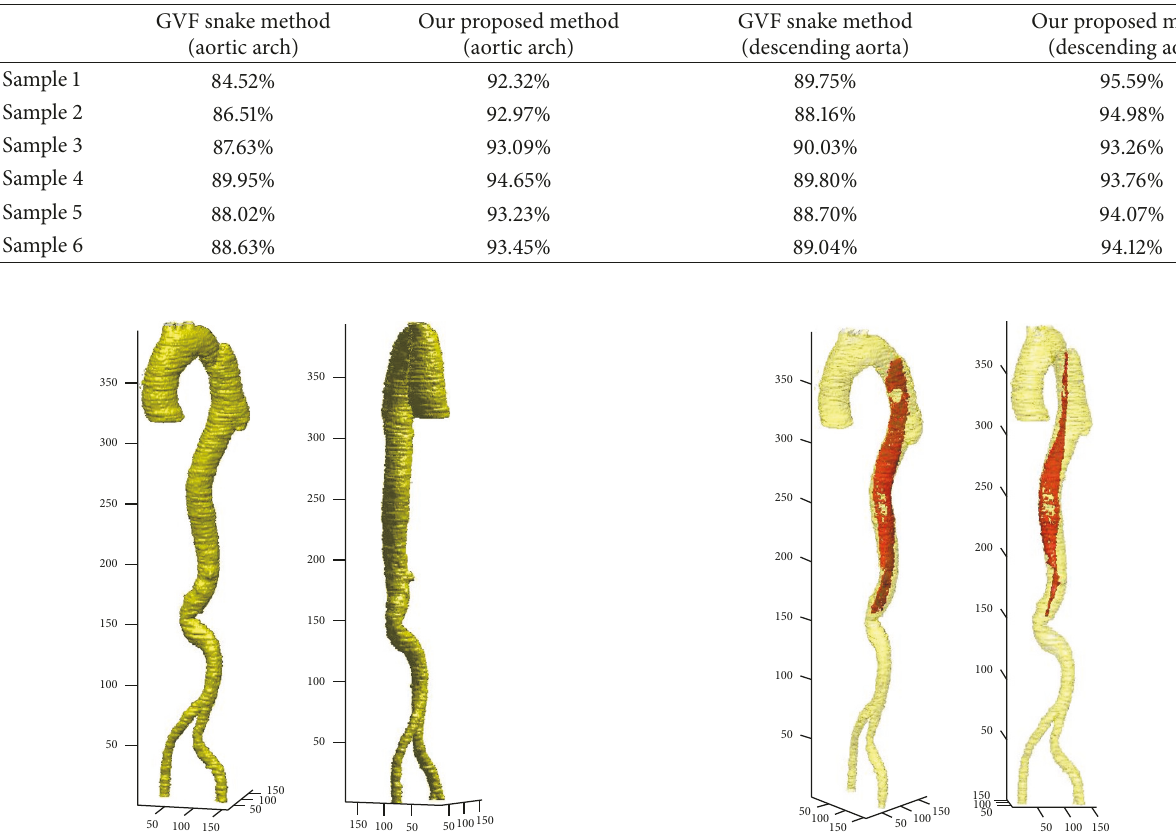
Table 1: Two segmentation algorithms’ overlap ratio.